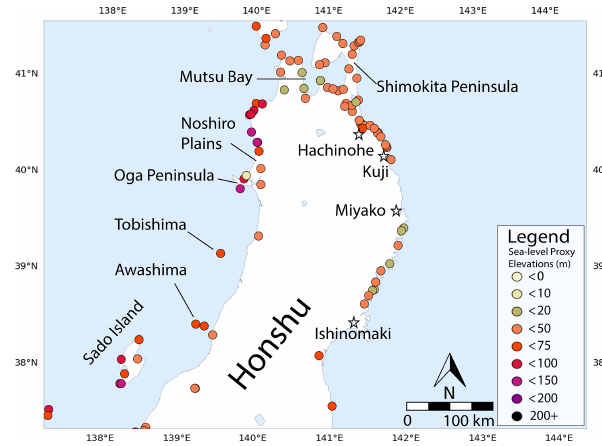
Figure 4. Sea-level elevation proxies in Hokkaido. Sea-level indi- cators (circles) with elevation range indicated by color (see legend). Reference cities are indicated by stars.